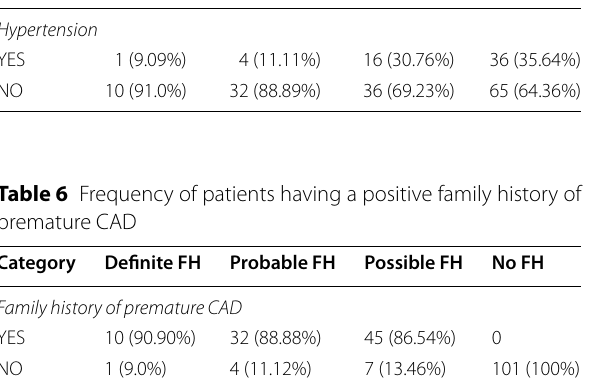
Table 5 Frequency of hypertension in FH patients Category